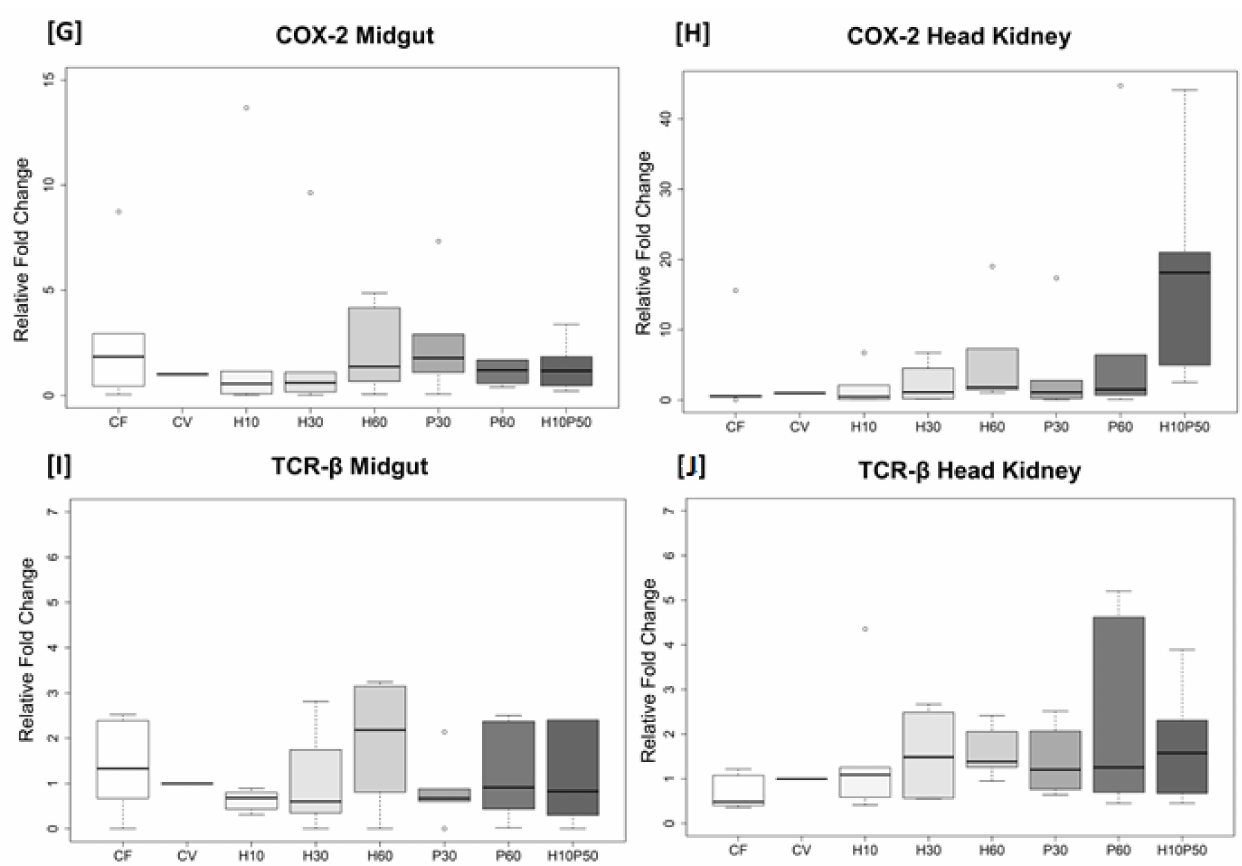
Figure 5. ( A – J ). Gene expression of IL-1 β , IL-10, TGF- β , COX-2m and TCR- β in midgut and head kidney biopsies ( n = 6 per diet) expressed as relative fold change 2 − ∆∆ Ct (CV = reference diet). The confidence interval box shows the 95% confidence interval for the median. ◦ = outliers. * p < 0.05 when compared with CV. Note the different scales on the y-axis.